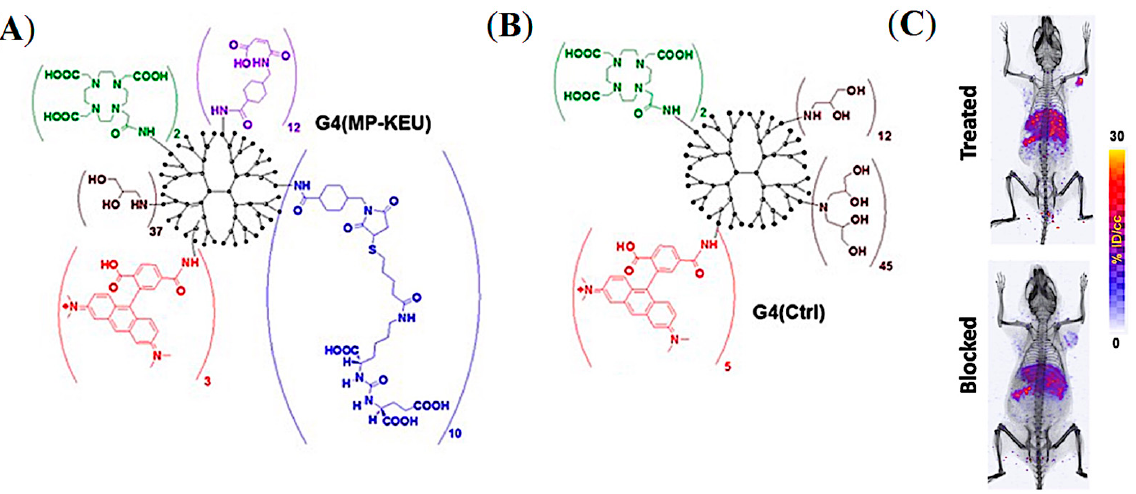
Figure 12. Representative chemical structures of ( A ) PSMA-targeted G4(MP-KEU) and ( B ) control G4(Ctrl) dendrimers. ( C ) Volume-rendered mPET/CT images of NOD-SCID mice model bearing dual xenografts of PC3-Pip and PC3-flu. Reprinted with permission from Ref [68]. Copyright 2019 American Chemical Society.